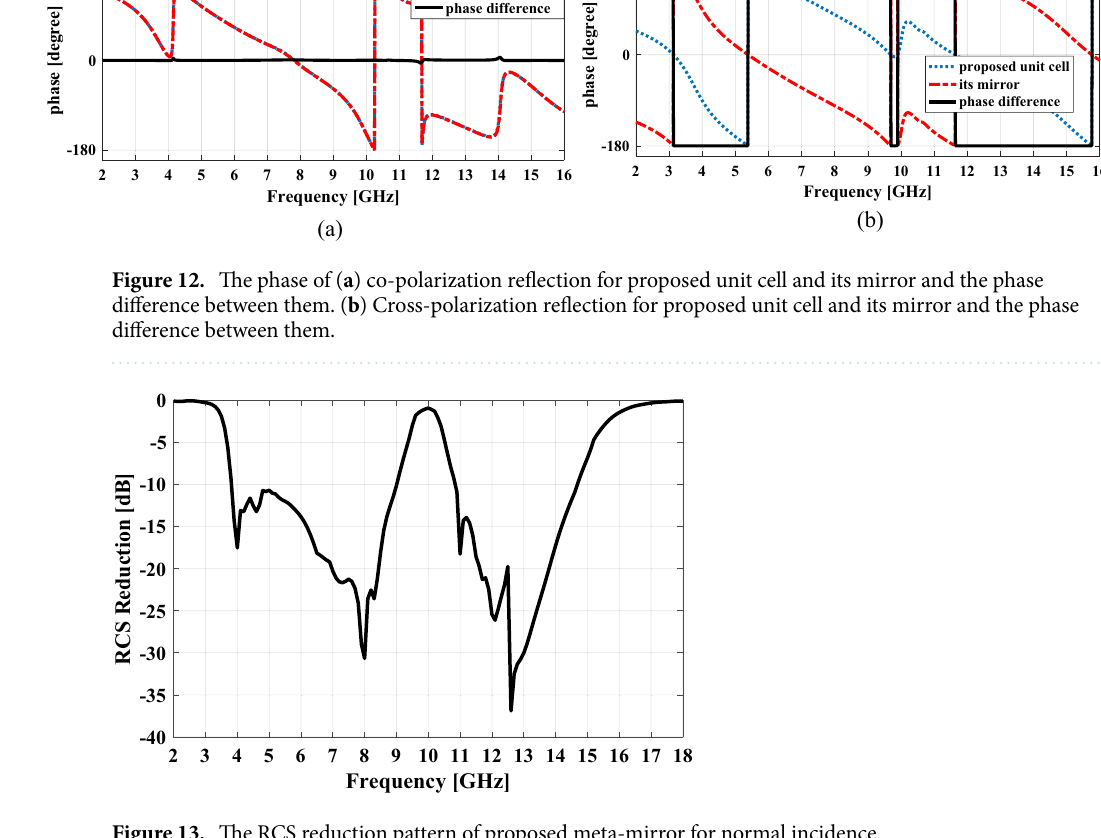
Figure 13. The RCS reduction pattern of proposed meta-mirror for normal incidence.